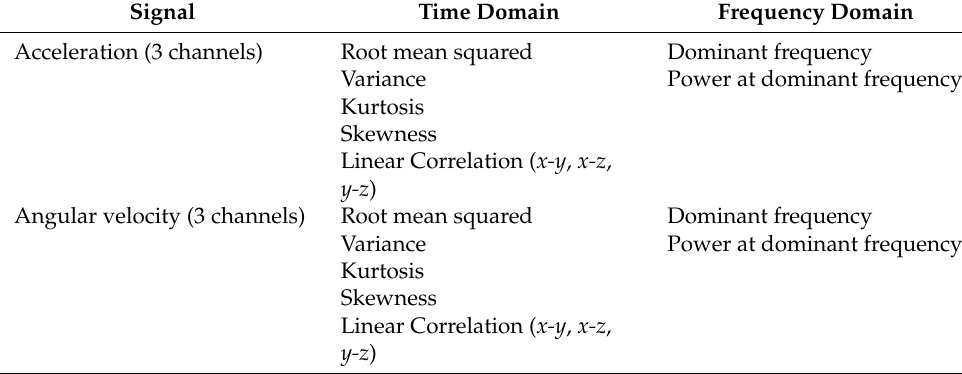
Table 1. Statistical and frequency-domain features.